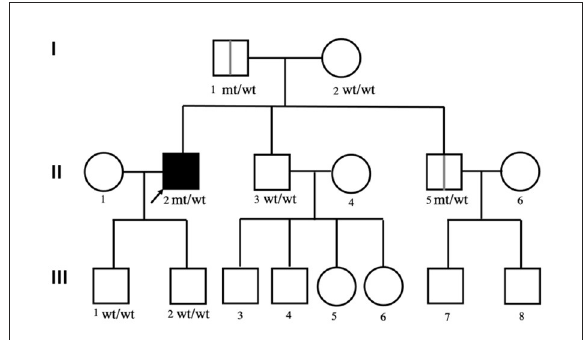
FIGURE1 The pedigree of the affected family. The squares indicate males; the circles indicate females; the black symbols indicate affected individuals; the arrow indicates the proband; wt/wt indicates homozygous wild-type.